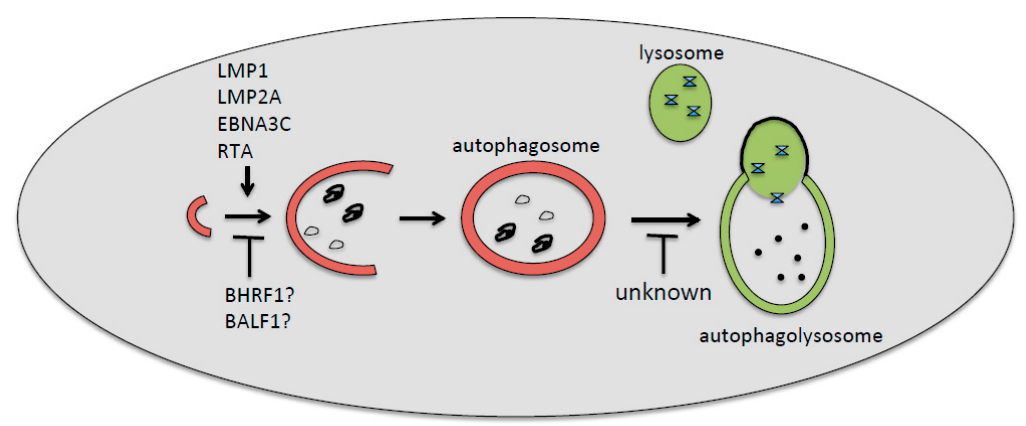
Figure 1. Epstein–Barr virus (EBV) ‐ encoded proteins involved, or likely involved, in the positive or negative regulations of the first (LMP1, LMP2A, EBNA3C, RTA, BHRF1, and BALF1) or the last (unknown) autophagic steps. The inhibition of the first steps of autophagy by EBV has been found during de novo infection of immune cells, whereas the inhibition of the last degradative phases has been found mainly during the viral reactivation from latency.